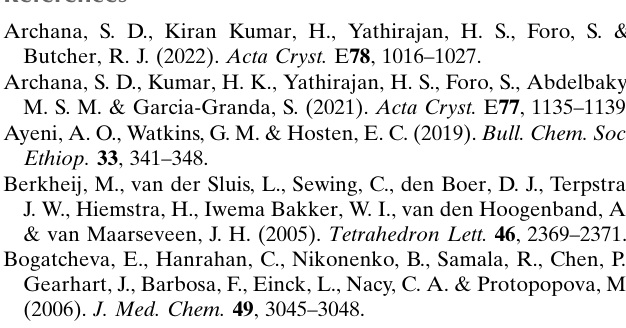
Crystal data Chemical